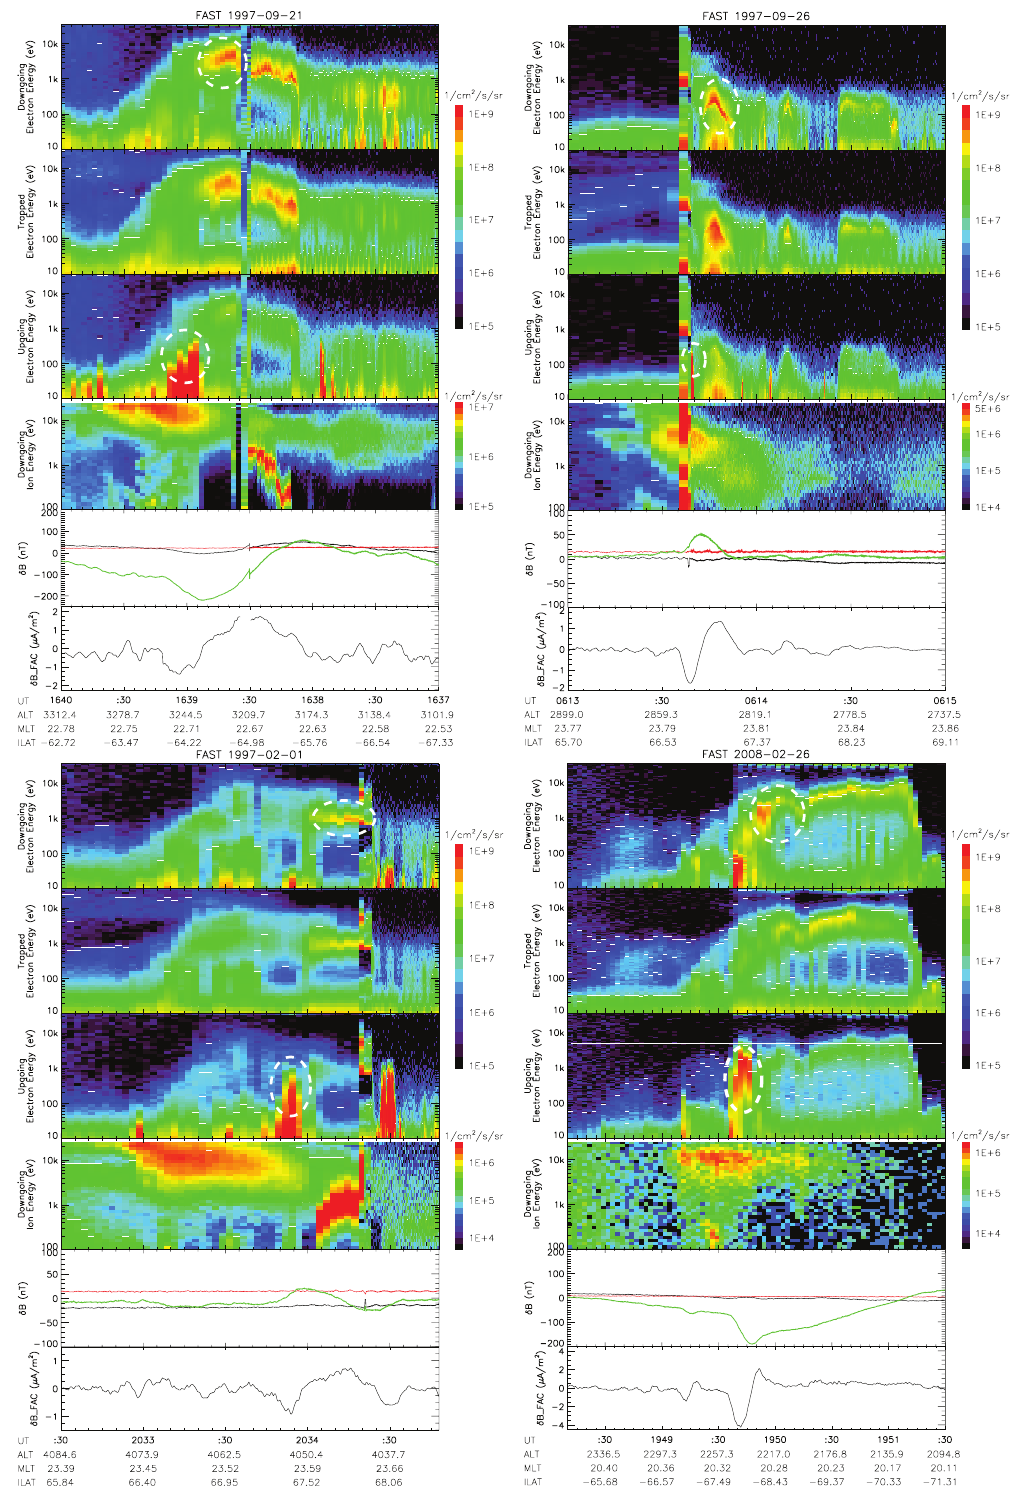
Fig. 1. FAST observations for four events. The plot format is identical for each event and subfigure. The top three panels show the electron energy flux spectrogram in downgoing, perpendicular, and upgoing directions. Two dashed circles serve to highlight the key structures of interest: the inverted-V arc and upgoing electron beam. The 4th panel shows the ion energy flux spectrogram in downgoing direction. the 5th panel show the deviations of magnetic fields: red, blue, and green curves denote the perturbations along the ambient B-field direction, along north–south direction (positive southward), and along east–west direction (positive eastward), respectively. The bottom panel shows the spin-smoothed FAC derived from the magnetic field deviations; negative (positive) values indicate downward (upward)